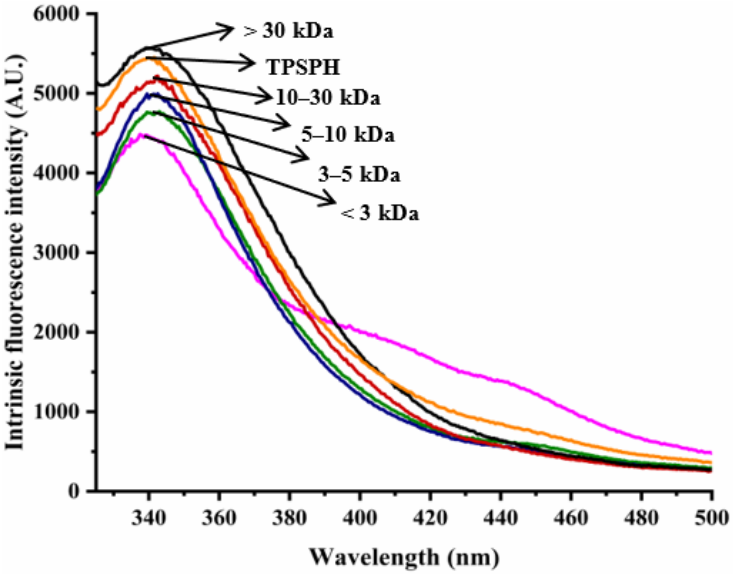
Figure 2. Intrinsic fluorescence spectra of TPSPH and five fractions.